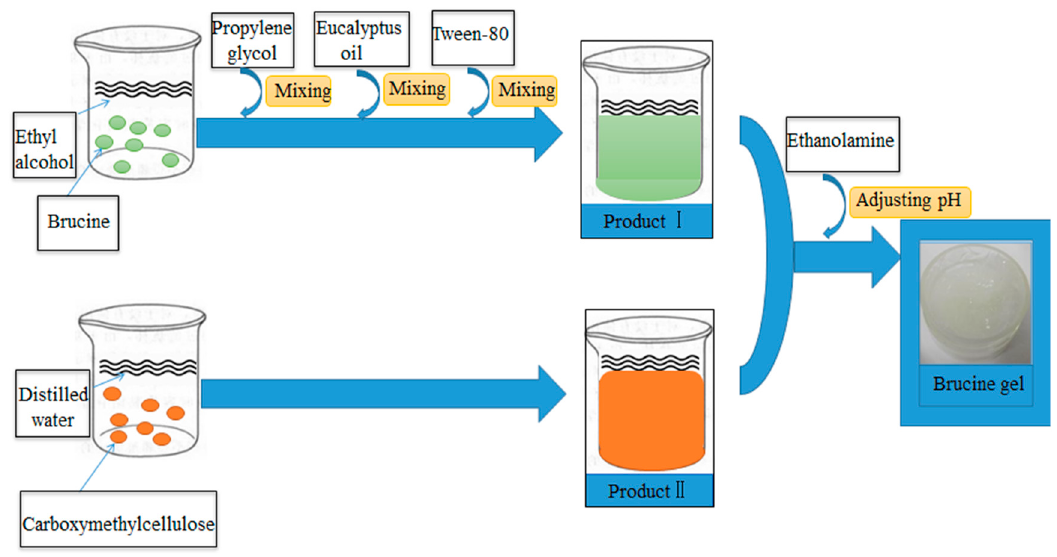
Figure 10. The fabrication process of brucine gel.